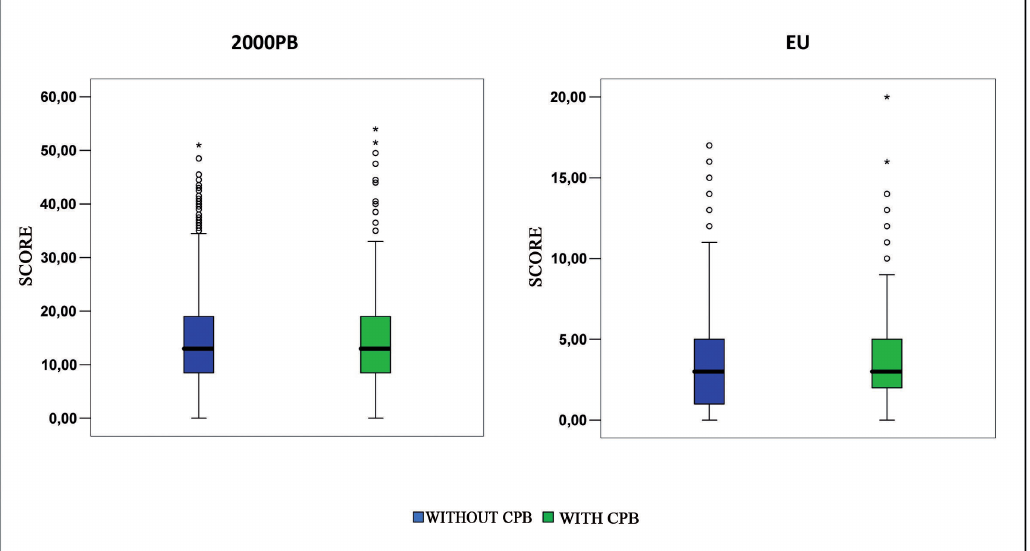
Fig. 4 - Diagram showing the presence of outliers after application of the 2000 Bernstein Parsonnet (2000BP) and EuroSCORE (EU) in patients with and without cardiopulmonary bypass for patients undergoing coronary artery bypass